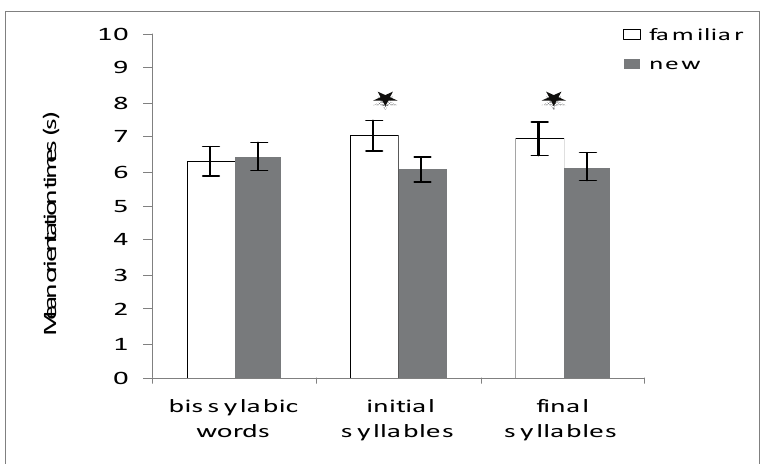
Figure 3: Mean orientation times (and standard error) to the test passages containing the familiar(ized) versus new items for 12-month-old French-learning infants, broken down according to the type of familiarization items: whole bisyllabic word (left panel); initial syllables (central panel); final syllables (right